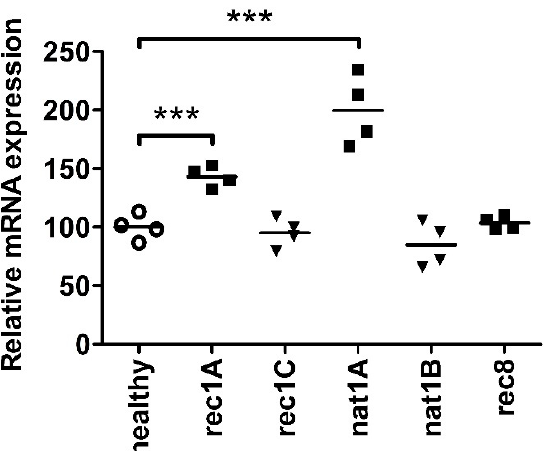
Figure 3. Perilipin-2 mRNA expression is increased in hPod exposed to active disease FSGS plasmas. hPod differentiated in T25 culture flasks (Corning) were exposed to FSGS plasmas. Active disease plasmas rec1A and nat1A increased PLIN2 mRNA expression compared to healthy plasma, whereas paired remission plasmas did not. Notably, active disease plasma rec8, which did not induce granularity, also did not increase PLIN2 mRNA expression. PLIN2 mRNA expression of two replicate experiments and their means relative to healthy plasma are depicted. *** p < 0.001 compared to healthy plasma. healthy: pooled plasma from five healthy donors; nat: patient with FSGS in the native kidneys; rec: patient with recurrent FSGS.